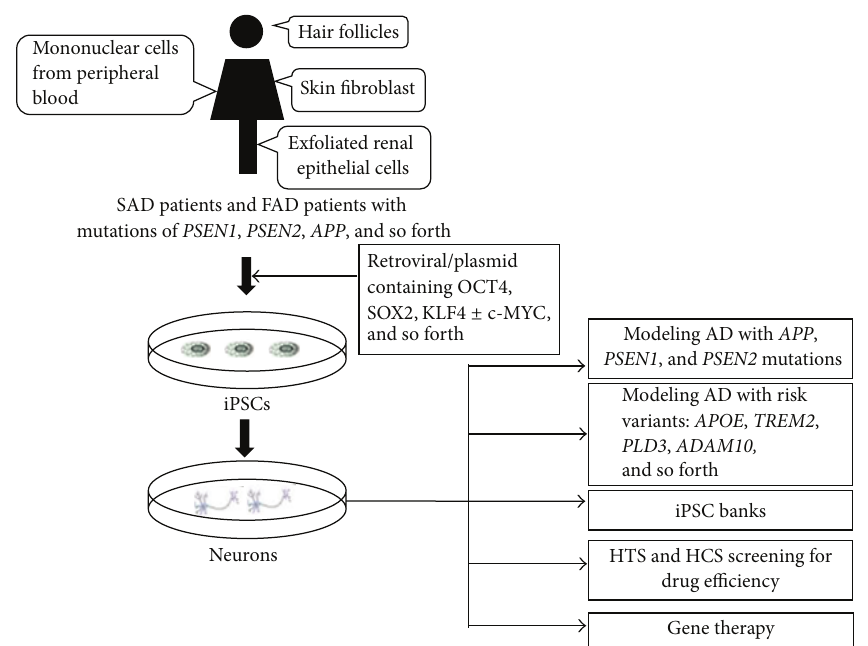
Figure 1: The generation of iPSCs and iPSC-derived neurons from various sources of somatic cells and application of iPSC in Alzheimer’s